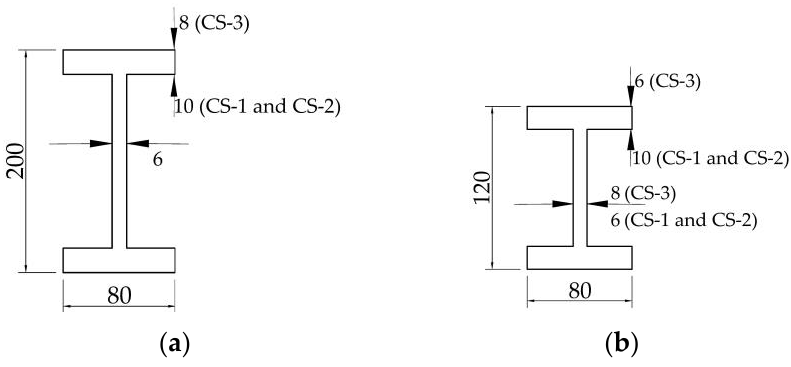
Figure 4. Details of SCBs and VBEs (unit: mm). ( a ) SCB; ( b ) VBE.